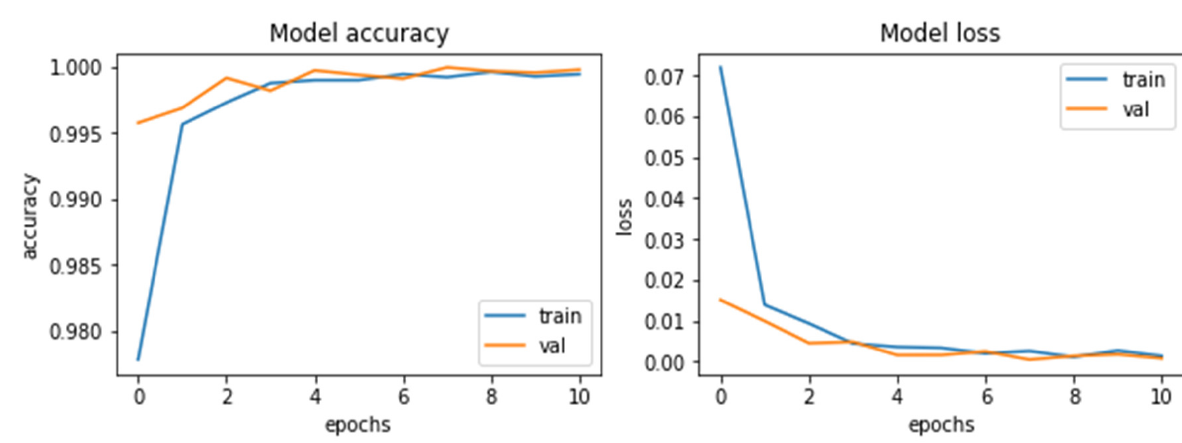
Figure 15. Accuracy and loss curves of VGG16 architecture.